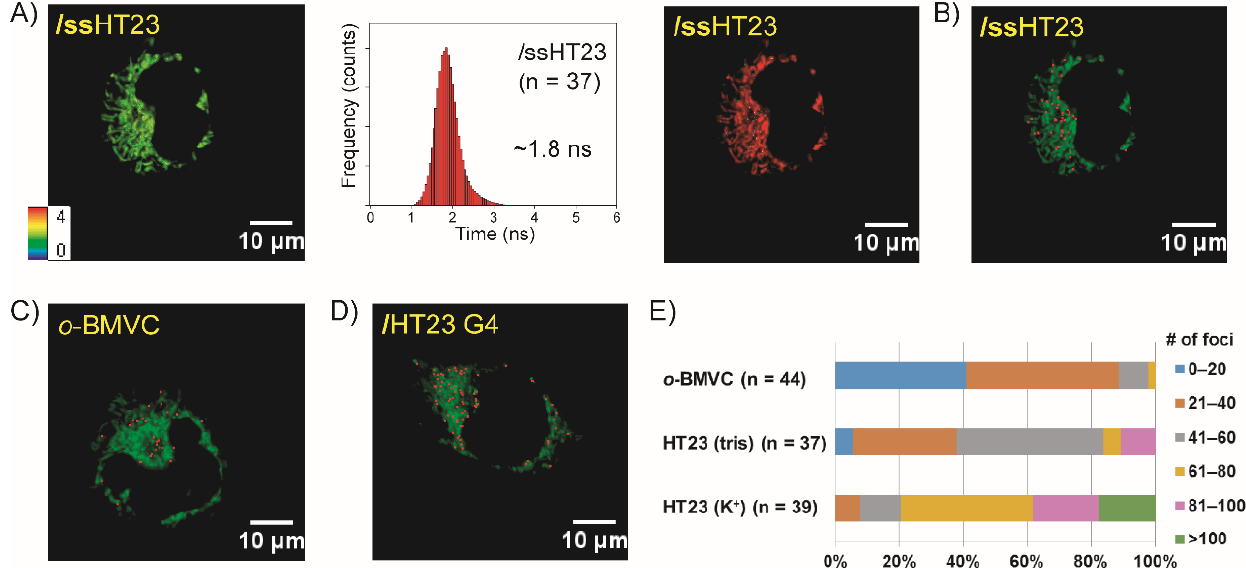
Figure 2. Imaging study of exogenous of HT23. FLIM images of ( A ) a mixture of 5 µ M o -BMVC and 15 µ M ssHT23 incubated with a live CL1-0 cell ( left ) and a histogram of the decay times of the o -BMVC fluorescence ( middle ) together with its time-gated image for 2 h ( right ). ( B ) Using the Otsu threshold method to analyze the time-gated FLIM image ( A , right ), the analyzed binary images were separated into two colors: red (decay time ≥ 2.4 ns) and green (decay time < 2.4 ns). The red spots were determind to be the o -BMVC foci. For comparison, the analyzed binary images of ( C ) o -BMVC and ( D ) the mixture of o -BMVC and HT23 G4s incubated with live CL1-0 cells for 2 h. ( E ) Quantitative analysis of the number of o -BMVC foci in these analyzed binary images. 2.3. FLIM Images of o-BMVC for Monitoring the Exogenous WT22 in CL1-0 Live